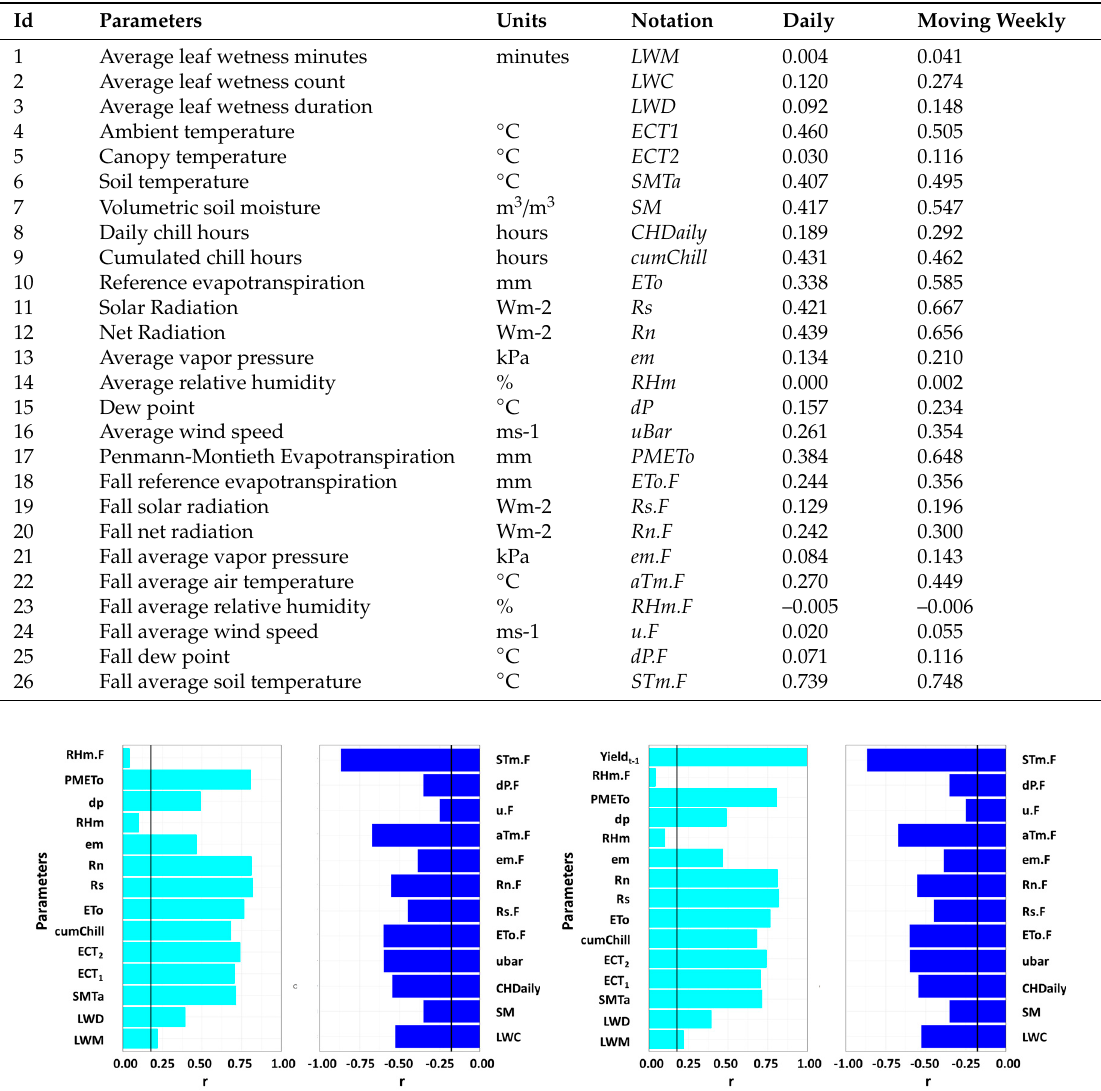
Table 3. The measured parameters, current, and lagged weather parameters including the adjusted R 2 for respective linear models.